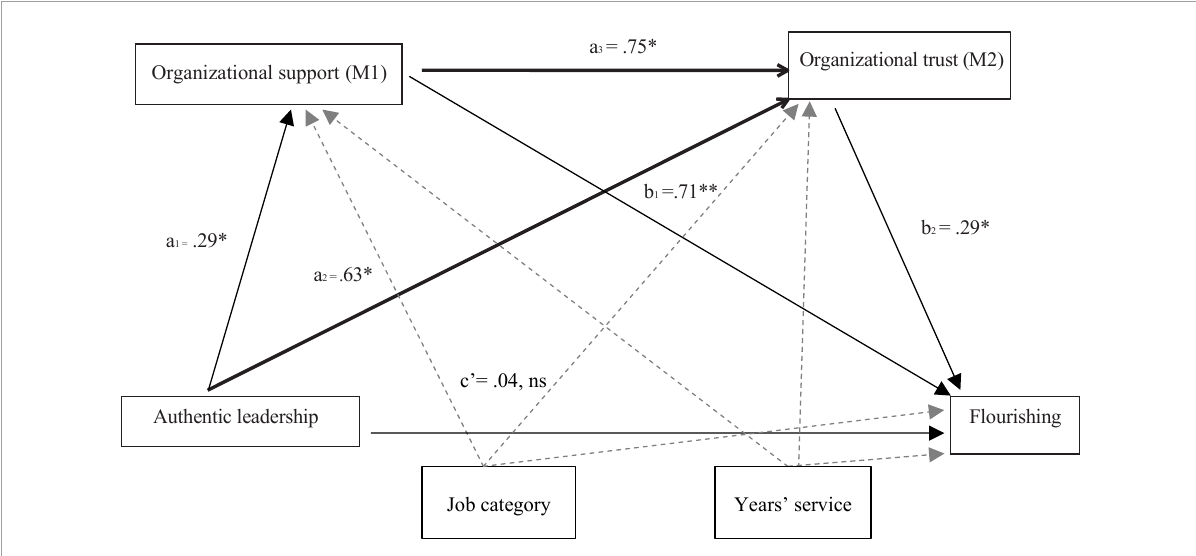
FIGURE1 Two-mediator sequential model depicting the relationship between authentic leadership and flourishing as mediated by organizational support and trust, controlling for job category, and years’ service in current position. Asterisks indicate significant coefficients ( ∗ p < 0.05).